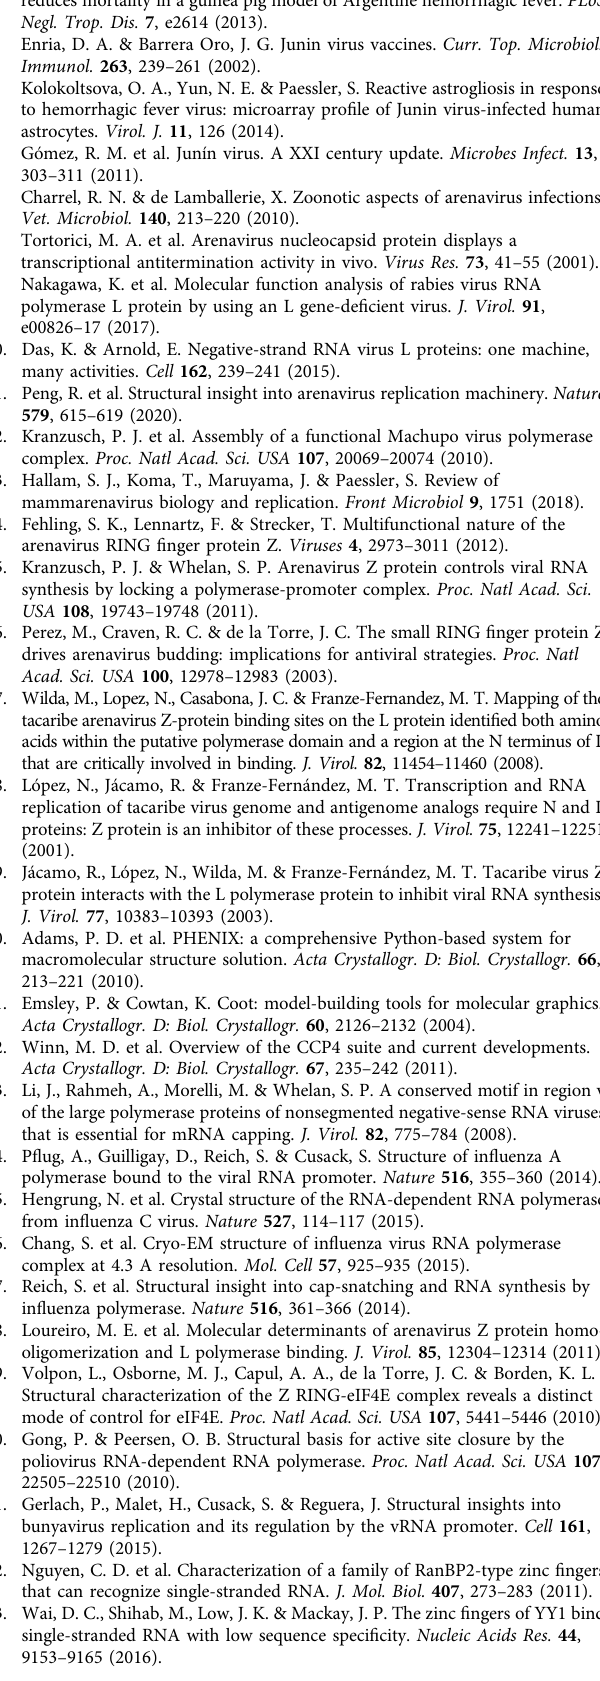
Figure preparation . All the representing model and electron density maps were generated using COOT 21 , UCSF Chimera 46 , and PyMOL 48 . Clustal X 49 and ESPript 50 were used to align multiple